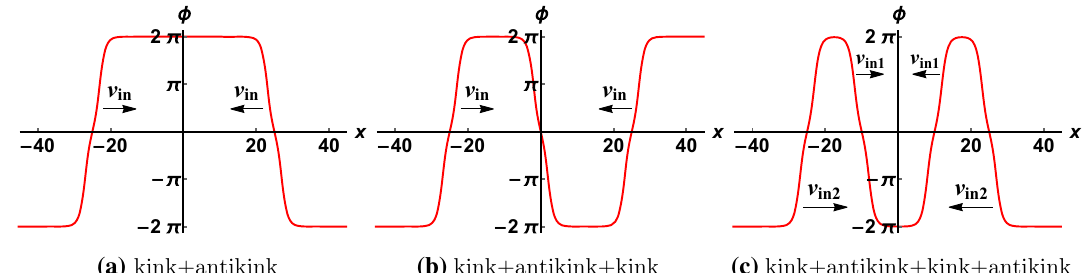
Fig. 3 The initial configurations for R = 2: a Eq. (19), b Eq. (20), c Eq.